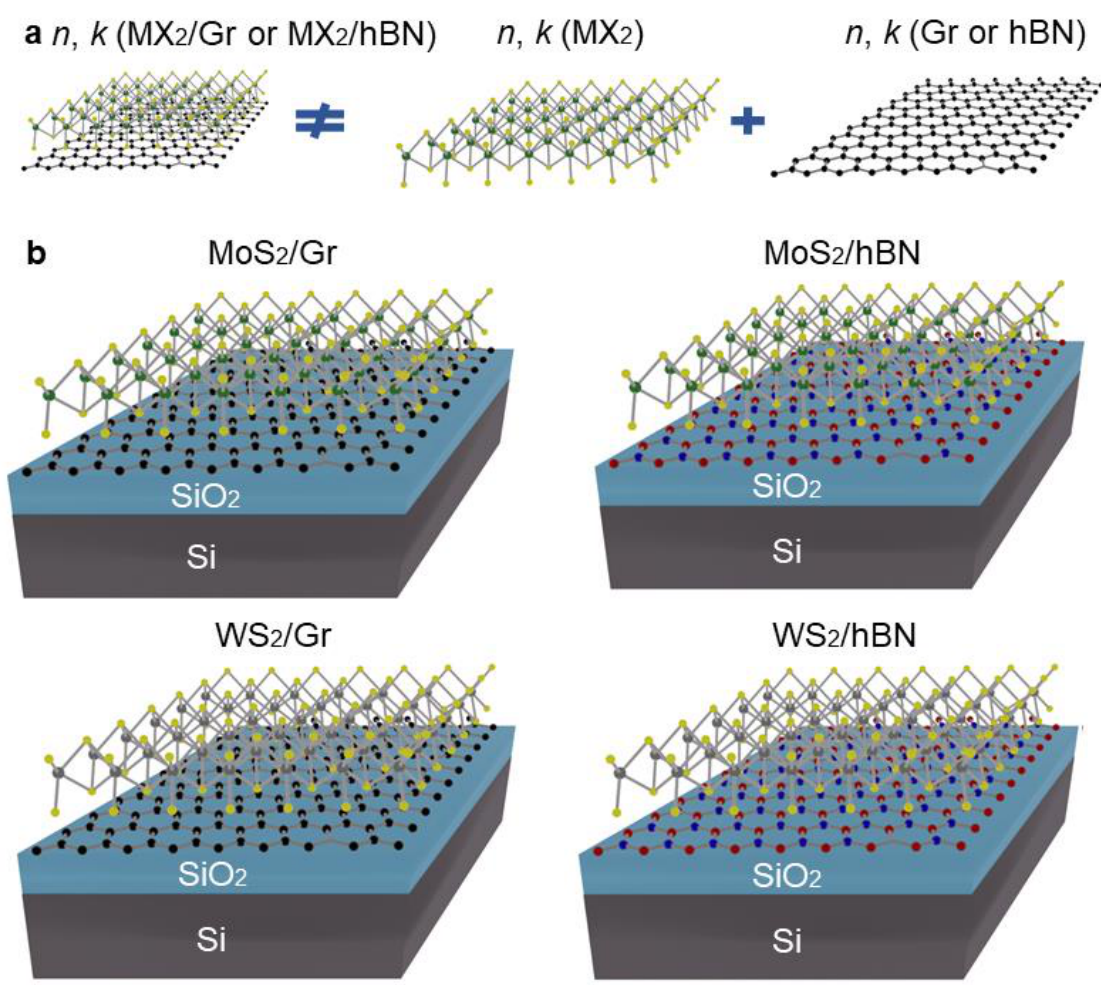
Figure 1. ( a ) Schematic illustration of non-additive optical response of heterostructures. ( b ) Heterostructures used in the work: MoS 2 /Gr, MoS 2 /hBN, WS 2 /Gr, and WS 2 /hBN. All vdW materials are single layers. Green, grey, yellow, black, red, and blue circles label Mo, W, S, C, B, and N atoms, respectively.